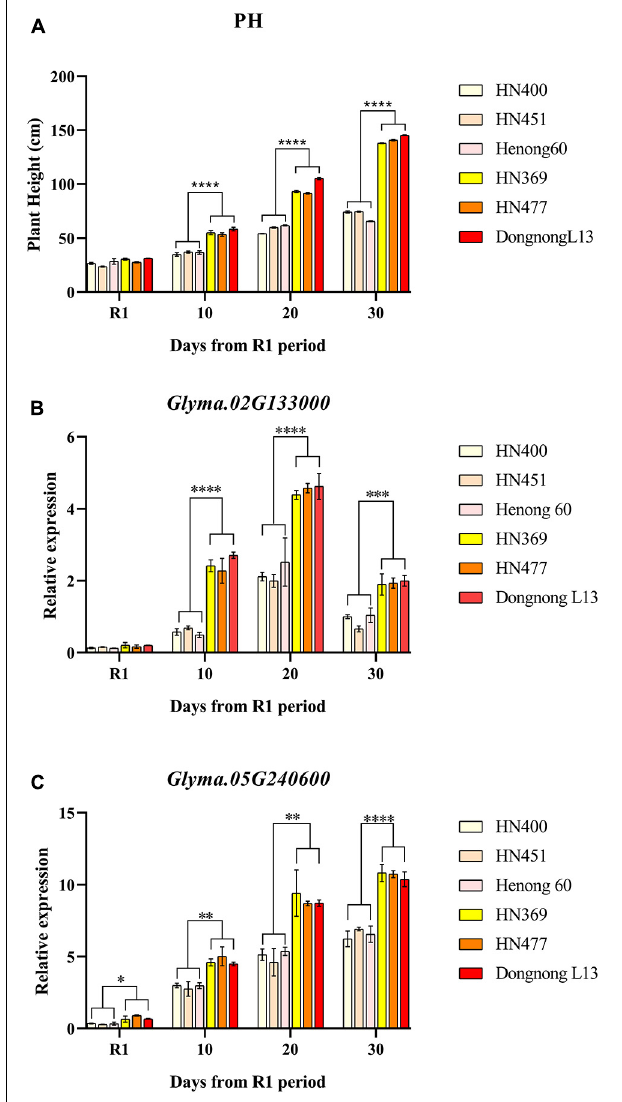
FIGURE 5 | Plant height and relative expression patterns of candidate genes. Plant height of six varieties at different times express as (A) , relative expression of Glyma.02G133000 in six varieties at different times express as (B) and relative expression of Glyma.02G133000 in six varieties at different times express as (C) . ∗ p < 0.05, ∗∗ p < 0.01, ∗∗∗ p < 0.001, ∗∗∗∗ p <